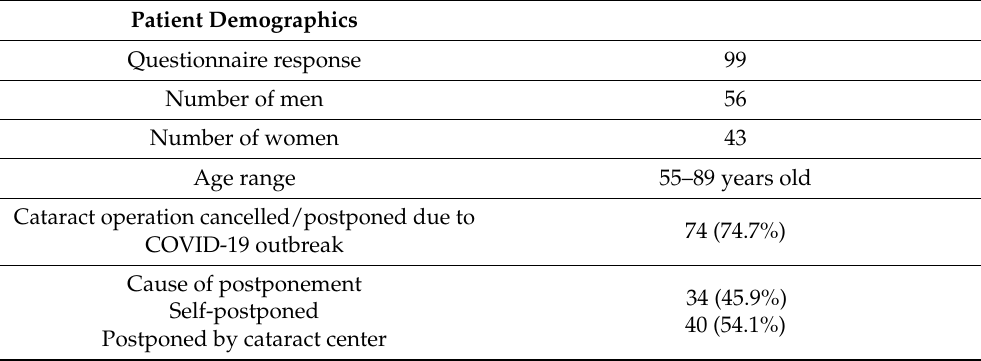
Table 1. Patient